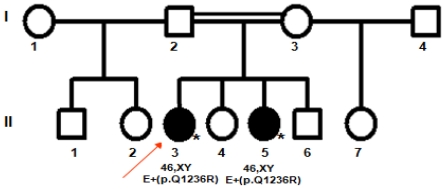
Family pedigree.